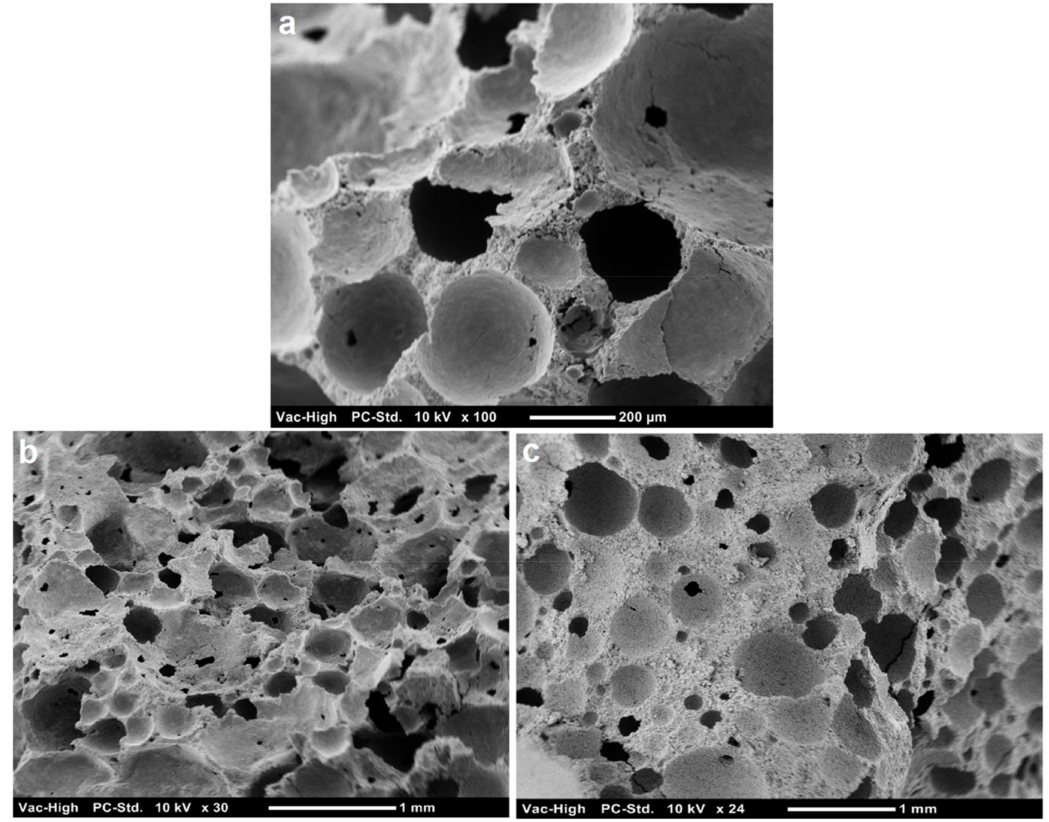
Figure 14. SEM images of the fractured surfaces of foam cements made from slurries after hydration for 28 days with a density of ( a ) 1.0 g/cm 3 ( b ) 0.75 g/cm 3 ( c ) 1.3 g/cm 3